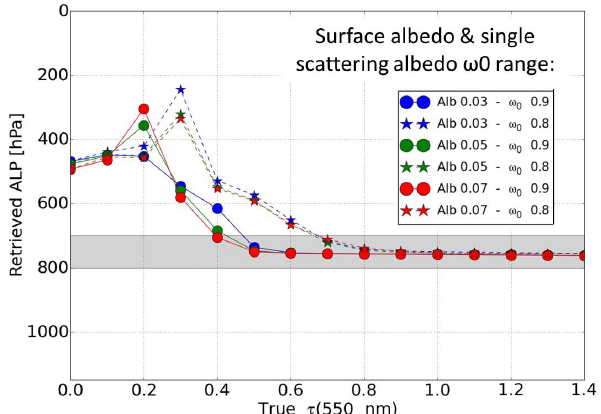
Figure 10. Simulated ALP retrievals, based on noise-free synthetic spectra with aerosols, as a function of true τ( 550nm ) . All the re- trievals are achieved with the NN algorithm trained with aerosol ω 0 = 0.9 and true prior τ( 550nm ) value. The assumed geophysi- cal conditions are temperature, H 2 O, O 3 , and NO 2 from climatol- ogy mid-latitude summer, θ 0 = 25 ◦ , θ = 45 ◦ , and P s = 1010hPa. The reference aerosol scenario assumes fine scattering particles ( α = 1.5, g = 0.7) and two aerosol ω 0 values: 0.9 and 0.8. Its lo- cation is depicted by the grey box, between 700 and 800hPa.